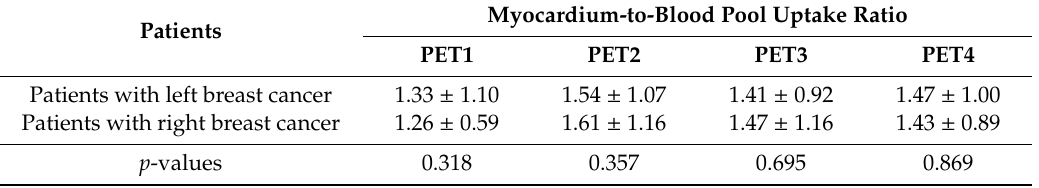
Table 2. The myocardium-to-blood pool uptake ratios in patients with left ( n = 55) and right ( n = 48) breast cancers. Myocardium-to-Blood Pool Uptake Ratio Patients PET1 PET2